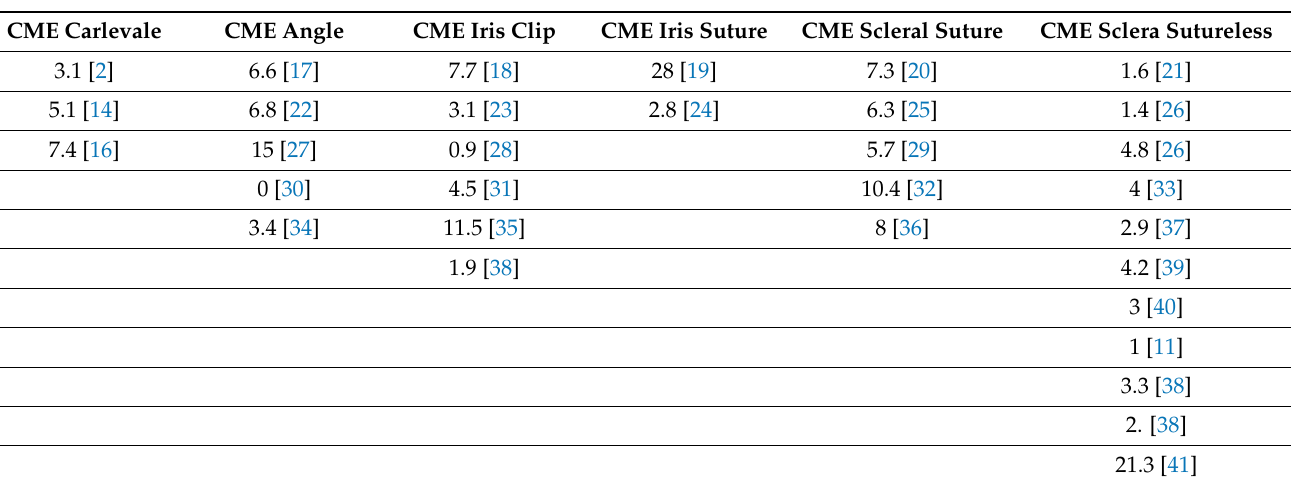
Table 4. Cystoid macular edema incidence of complications of different